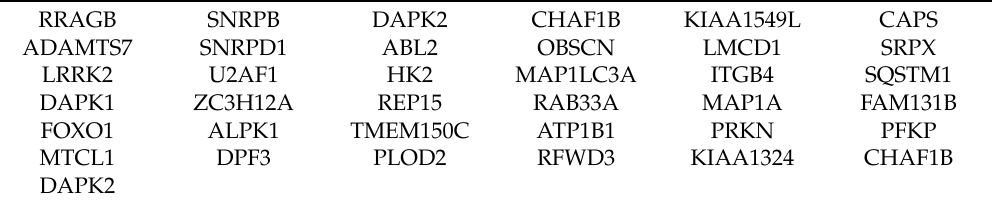
by adjusting the p -value with the Benjamini–Hochberg algorithm.